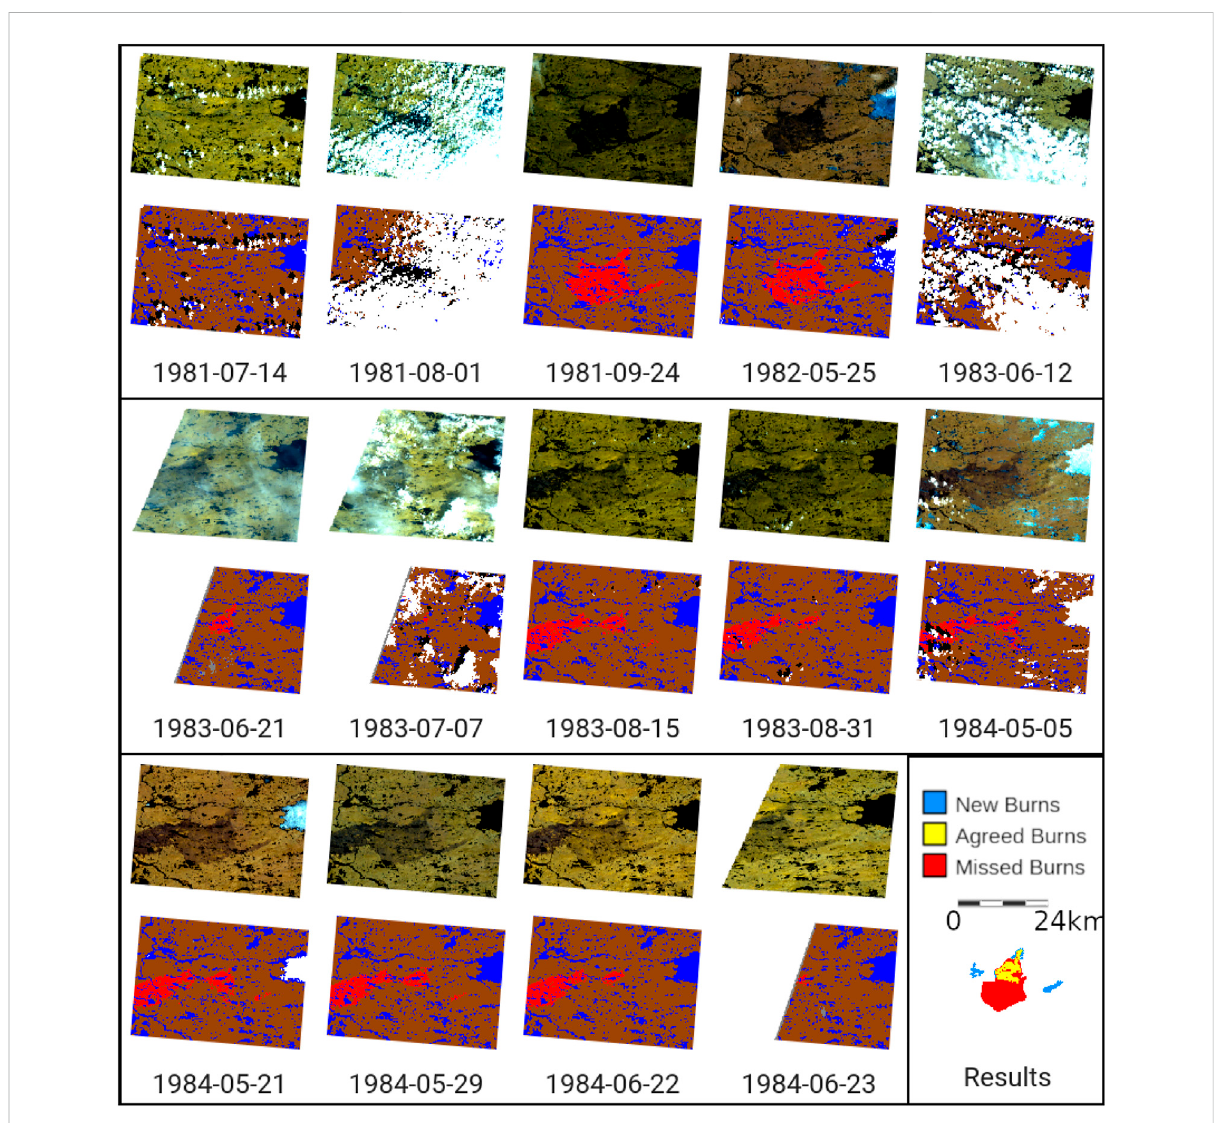
FIGURE 11 Results Detail I. Every usable MSS image and UNet classi fi cation of a fi re that started 1981 – 07-06 accordig to the CNFDB, but was only partially detected by our